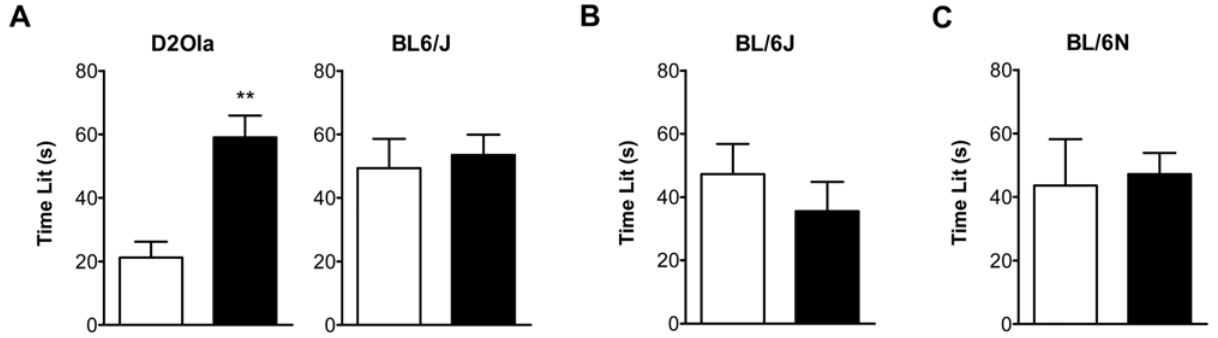
Figure 2. CMS effects on time spent in the lit compartment of the DaLi. (A) In D2Ola mice long-lasting CMS exposure (11 weeks) led to behavioural changes reflected by an increase in time spent in the lit compartment (700 lx) compared to the control group. In BL/6J mice with similar CMS experience no changes were observed. (B) BL/6J mice with CMS experience of 2 weeks were also unaffected in terms of time spent in the lit compartment (700 lx). (C) BL/6N mice with CMS experience of 4 weeks did not differ from control mice in the parameter time lit, when tested at a moderate illumination level of 50 lx in the lit compartment. Data represent mean + SEM, n=9–20/group. White bars: control group, black bars: CMS group. ** p , 0.01 (Student’s t-test).